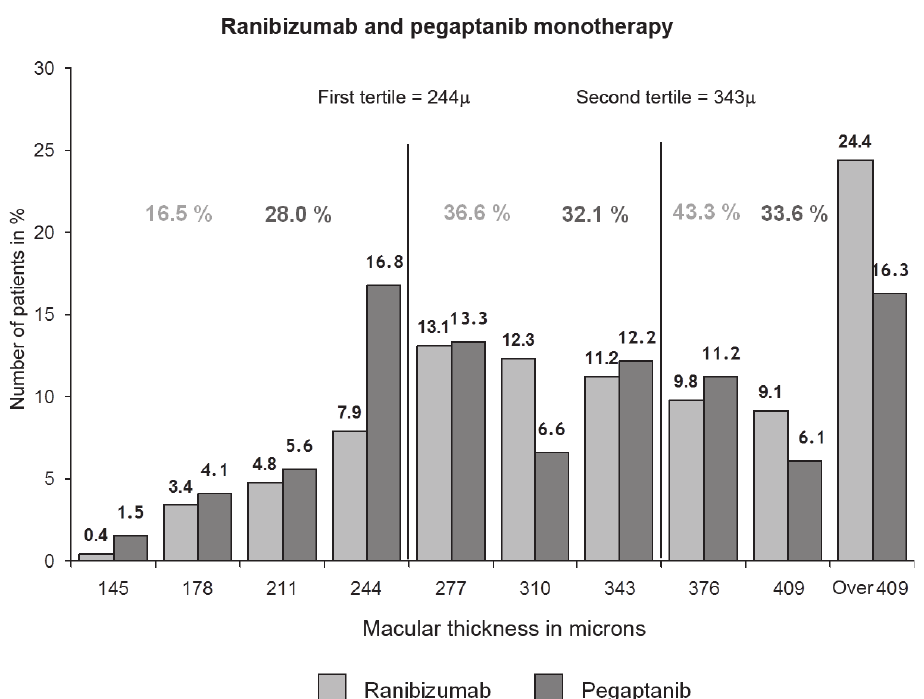
Fig. 1. Macular oedema height measured in OCT at the initiation of the